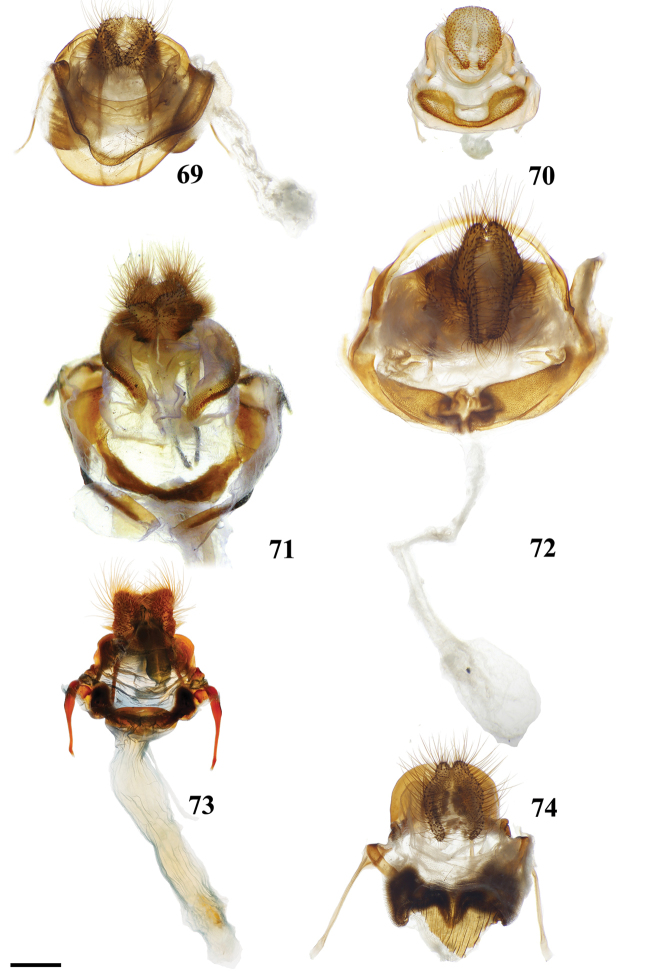
Ventral view of female genitalia of type species (except where noted) of genera belonging to Cicinninae: Cicinnini. 69Aceclostriamus, St Laurent diss.: 3-31-18:8 (CRAS) 70Aleydaaccipiter, St Laurent diss.: 4-24-17:1 [reused with permission from St Laurent et al. (2018b), SHILAP) (CUIC) 71Cicinnuscforthane, C. Mielke diss. 34365, elongated ductus and corpus bursae not figured [reused with permission St Laurent et al. (2018c), Zootaxa] (CGCM) 72Euphanetaromani, St Laurent diss.: 3-31-18:9, not the type species of Euphaneta (MGCL) 73Isoscellaventana, St Laurent diss.: 3-7-16:1 [reused with permission from St Laurent and Carvalho (2017b), Journal of the Lepidopterists’ Society] (AMNH) 74Roelmanamaloba, St Laurent diss.: 3-31-18:10, corpus bursae not figured (CRAS). Scale bar: 1 mm.